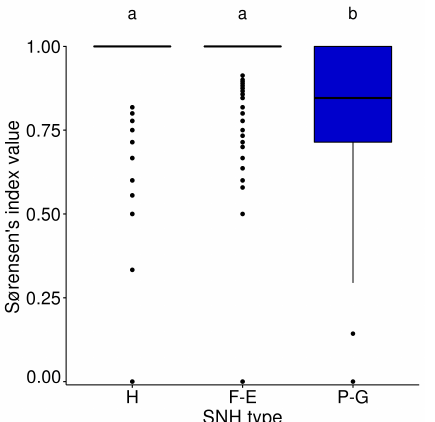
Figure 5. Boxplots of Sørensen’s index between sampling points of each type of SNH (H: hedgerows, F-E: forest edges and P-G: permanent grasslands). The letters above each plot indicate significant differences between types of SNH after multiple comparisons (Dunn’s test) following the KW test. Boxplots represent median value, first and third